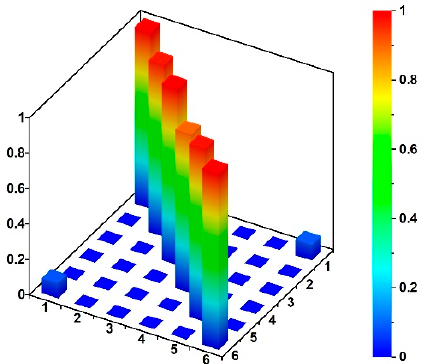
Figure 19. 3D visualization of the MAC values showing the correlation between numerical and experimental modal models. Table 5. Natural frequencies: theoretical and numerical vs. experimental values for the FIX_Ovhg and SPRING_Ovhg models of the footbridge.